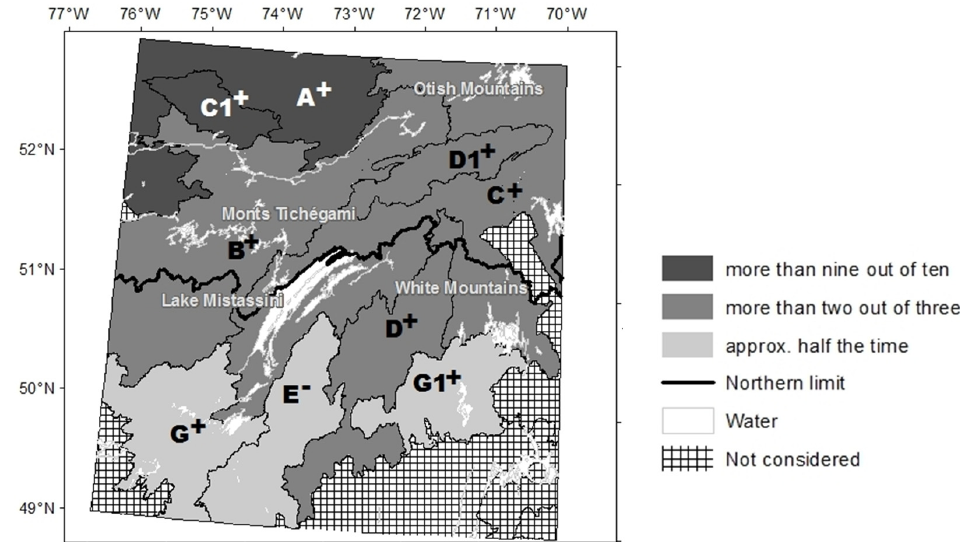
Figure 7. Frequency of change in the abundance of open stands after 150 years of simulation of a forest succession model in interaction with natural disturbances.